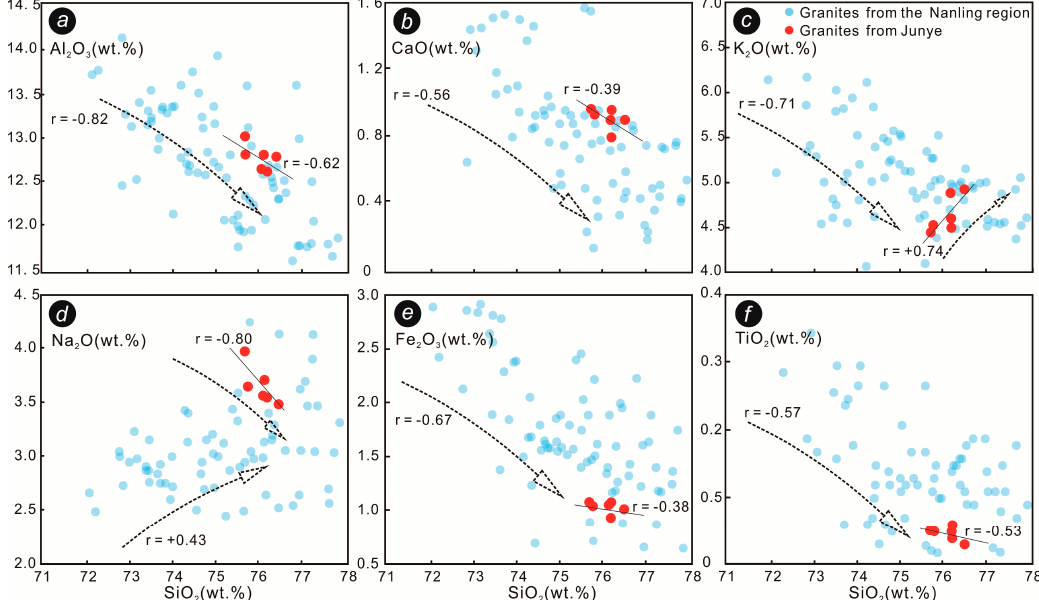
Figure 5. Harker diagrams that show Al 2 O 3 , CaO, K 2 O, Na 2 O, Fe 2 O 3 and TiO 2 as a function of SiO 2 . The compositions of major elements for granites in the Nanling area are from Zhang et al. [35], Huang et al. [23], Yu et al. [38], Zhou et al. [16], Liu et al. [43] and Gu et al. [25]. ( a ) Al 2 O 3 vs. SiO 2 , showing moderate to strong negative correlation between Al 2 O 3 and SiO 2 ; ( b ) CaO vs. SiO 2 , displaying moderate to weak negative correlation between CaO and SiO 2 ; ( c ) K 2 O vs. SiO 2 , showing strong negative correlation for granites from the Nanling region and strong positive correlation for granites from the Junye between K 2 O and SiO 2 ; ( d ) Na 2 O vs. SiO 2 , displaying moderate positive correlation for granites from the Nanling region and strong negative correlation for granites from the Junye between Na 2 O and SiO 2 ; ( e ) Fe 2 O 3 vs. SiO 2 , showing weak to moderate negative correlation between Fe 2 O 3 and SiO 2 ; ( f ) TiO 2 vs. SiO 2 , displaying moderate negative correlation between TiO 2 and SiO 2 .